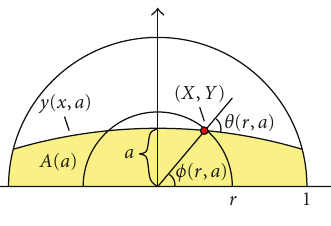
Figure 7: Notation for basic paths.